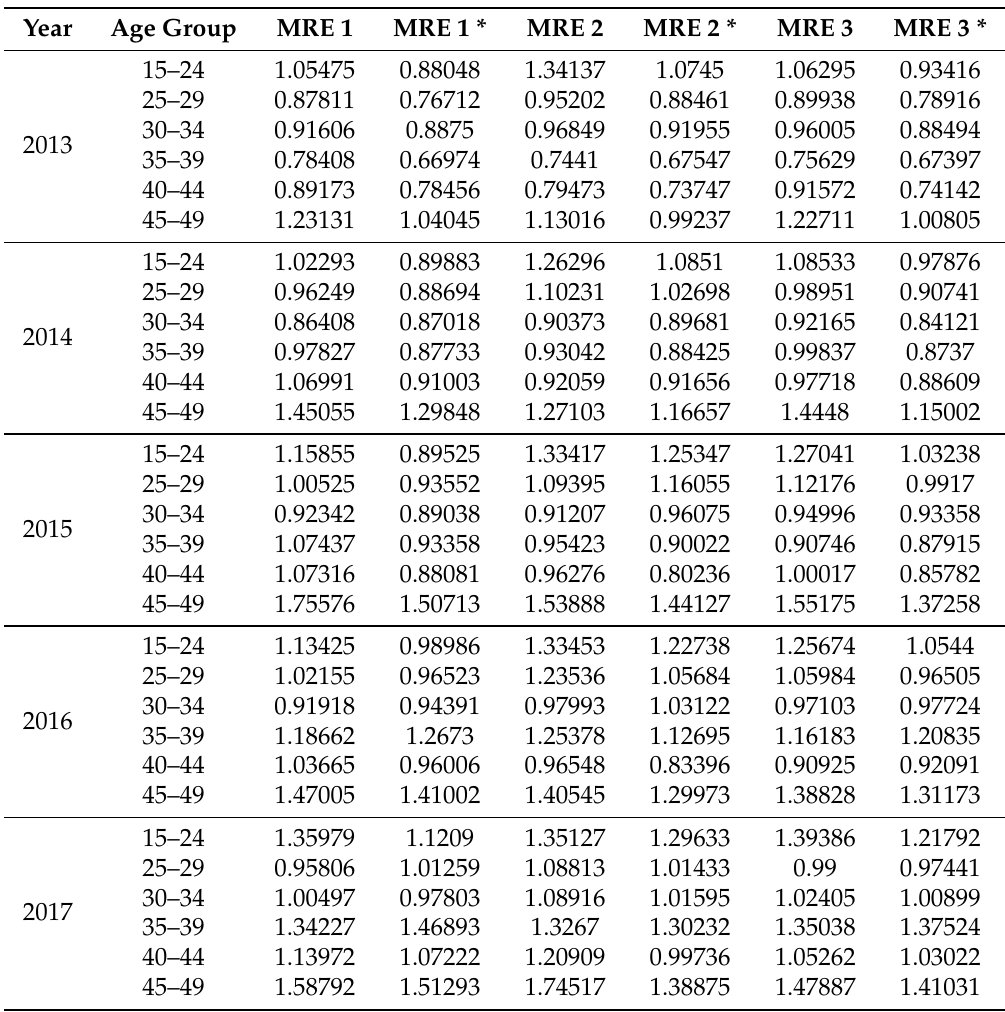
Table 5. Mean relative error for average incidence values in male populations compared between benchmark data and after calibration with HIV epidemiology and sexual behaviour (MRE 1), phylo- genetic tree (MRE 2), and a combination of the two types of features (MRE